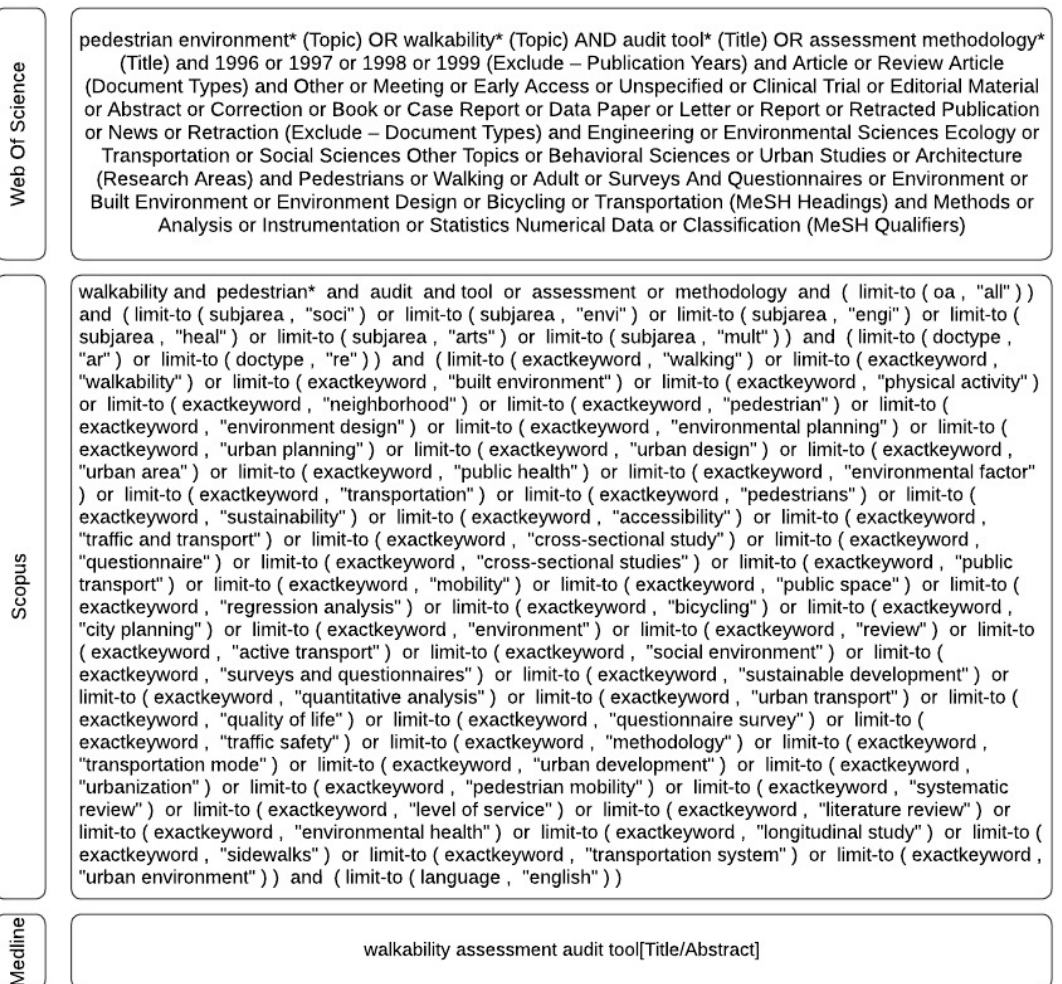
Figure 2. Chart of the search strategies for WoS, Scopus, and MEDLINE. The * symbol is added as a expanded search symbol. It search sufixses, prefixes, or spelling variations etc.